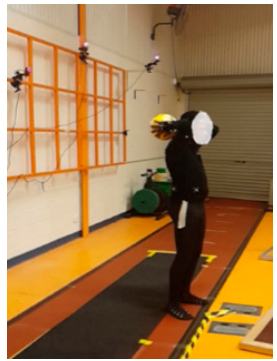
Figure 1. Ball throw-in experiment using infrared Optitrack